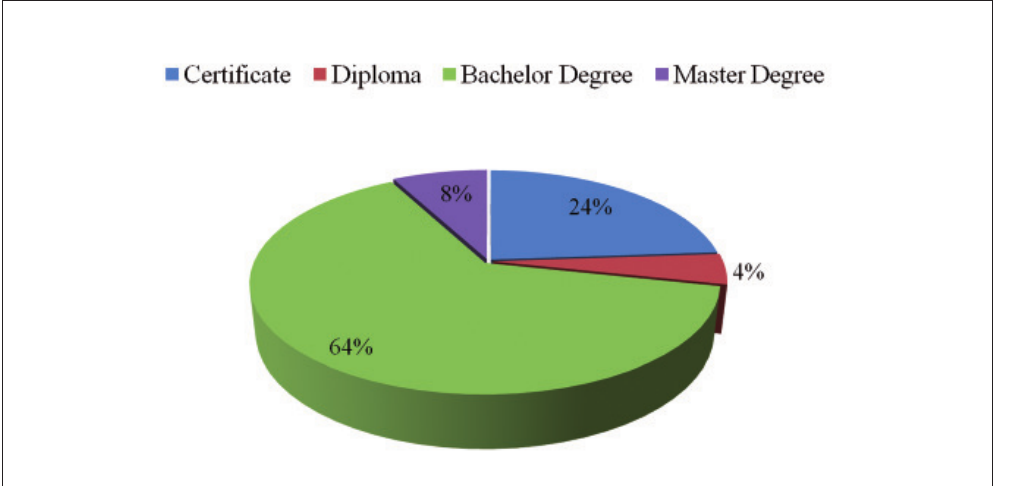
Figure 4 Status of inmate students in the Tihar Study Centre Source: Enrolment list of IGNOU Tihar Study